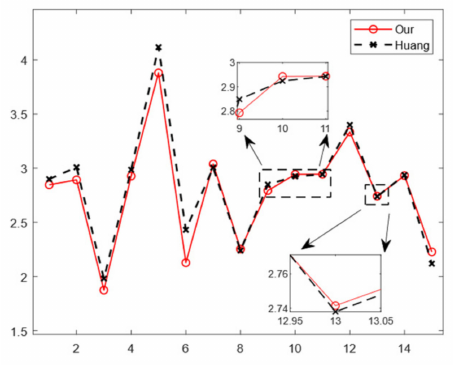
Figure 6. NIQE index